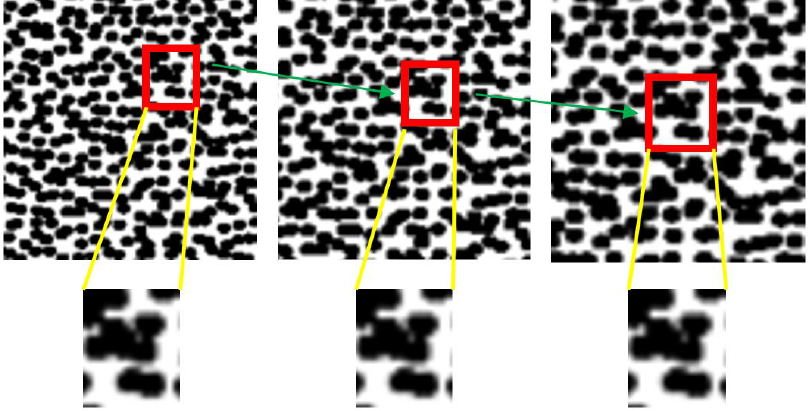
Figure 2. Deformation of the evaluation window during the measurement (on the basis of [30]).